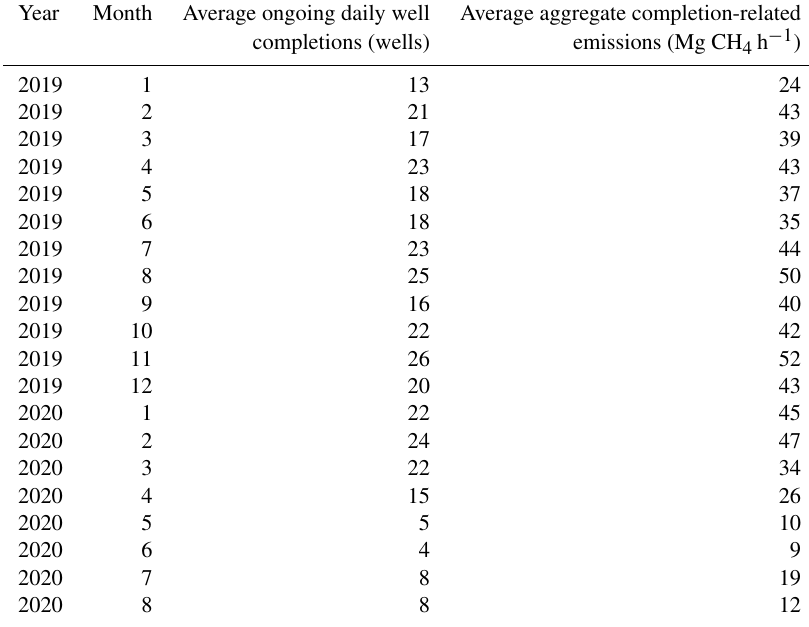
Table D2. Estimate of average monthly potential completion-related emissions from our study area from January 2019–September 2020 based on initial gas production data and the assumption of 4d completion